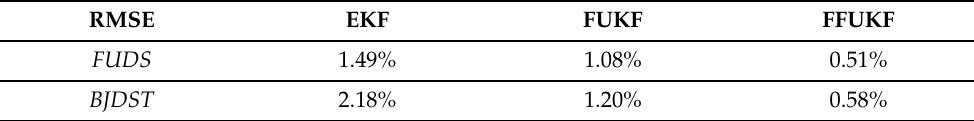
Table 5. The RMSE under BJDST and FUDS at 45 ◦